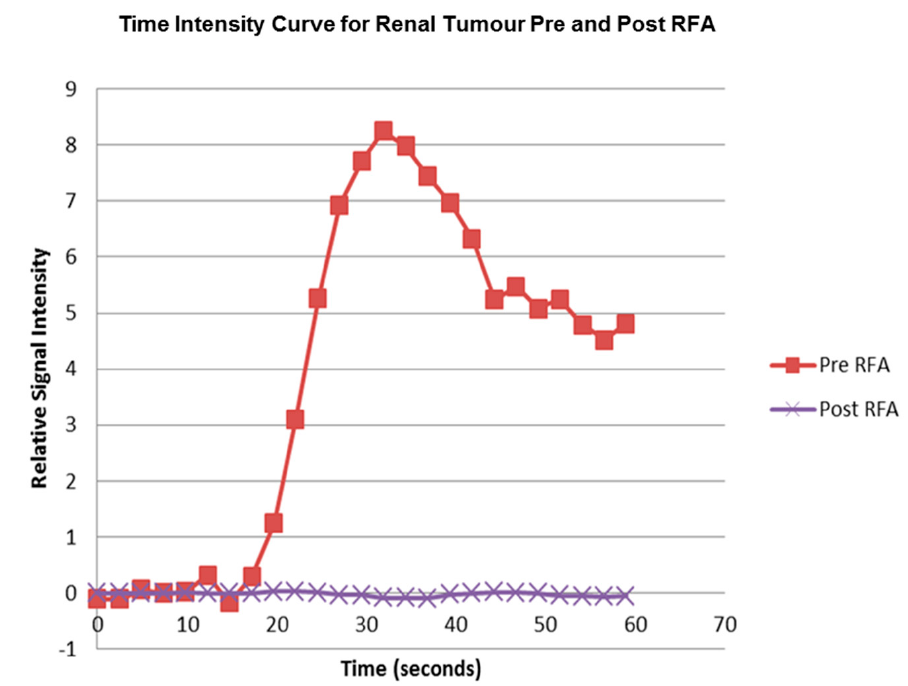
Figure 5. The time intensity curve produced by the PMI 0.4 Software for the right renal tumour as outlined in Figure 2 ROI using the maximum slope technique before and after RFA treatment.